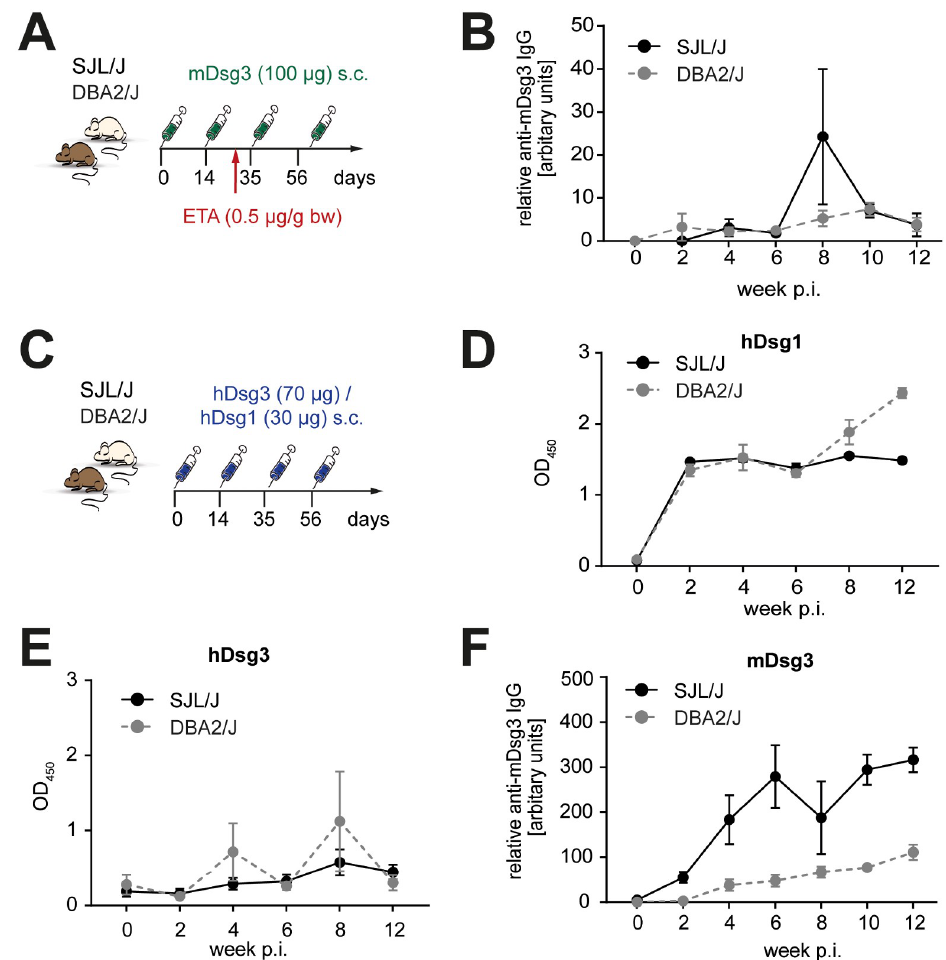
Fig 2. Immunization with murine desmoglein 3 and additional ETA or human desmoglein induce antibodies against Dsg3, but no clinical PV phenotype. (A) Modified 4x immunization protocol (additional injection of 0.5 μ g/ ml ETA at day 28) was tested in DBA2/J and SJL/J mice on day 0, 14, 35, 56. The s.c. immunization was carried out with 100 μ g mDsg3 emulsified in TiterMax ™ . (B) Dsg3-specific IgG autoantibody titers of DBA2/J mice (n = 4) and SJL/J mice (n = 3). (C) Modified 4x immunization protocol was tested in DBA2/J and SJL/J mice on day 0, 14, 35, 56. The s.c. immunization was carried out with 30 μ g human (h) Dsg1 and 70 μ g hDsg3 emulsified in TiterMax ™ (C). IgG autoantibody titers of DBA2/J mice (n = 4) and SJL/J (n = 5) were analyzed for their activity against (D) hDsg1, (E) hDsg3 and (F) cross-reactivity with mDsg3. production of anti-Dsg3 antibodies which did not bind to mouse skin but induced the loss of cell-cell adhesion ex vivo [5]. Thus, in subsequent experiments, DBA2/J (n = 4) and SJL/J (n = 6) mice were immunized with hDsg1/3 (Fig 2C). These experiments were also seen as a potential alternative strategy because the homology of mDsg3 and hDsg3 is as high as 85.6% [18, 19]. In line with these findings, VH1-46 antibody heavy chain gene usage by Dsg3-reactive B cells is commonly observed in PV [20] and, interestingly, the pathogenic mouse monoclonal anti-Dsg3 antibody (AK23) [14] is transcribed from a gene that is highly homologous to the human VH1-46 gene, pointing to the similarity in response to Dsg3 in humans and mice. As in the previous experiments, despite the presence of circulating anti-human Dsg1/3–reactive IgG (Fig 2D and 2E), the mice did not develop PV-like skin changes (S2 Table). Similar to the